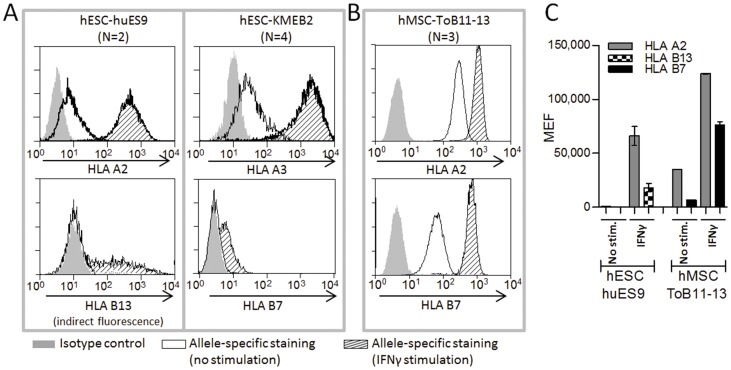
Expression of HLA-A and HLA-B in hESC and hMSC.Representative flow histograms showing HLA-A and -B expression in stem cell lines using allele-specific antibodies (anti-A2, -A3, -B7, and -B13). (A) In separate experiments, hESC lines (huES9 and KMEB2) showed a low expression of HLA-A alleles (A2 and A3, respectively) and no expression of the HLA-B alleles (B13 and B7, respectively). IFNγ stimulation up-regulated HLA-A alleles and induced of modest expression of HLA-B alleles. (B) Panel B shows representative flow histograms of an hMSC cell line (ToB11-13) both un-stimulated and IFNγ stimulated (72 hr) demonstrating a high constitutive expression of HLA-A2 and a relatively low expression of HLA-B7. Both antigens were up-regulated after stimulation with IFNγ. Panel (C) compares the expression of HLA-A and HLA-B between hESC (huES9) and hMSC (ToB11-13) during basal, un-induced conditions and after stimulation for 72 h with 25 ng/µl IFNγ. HLA expression was measured by flowcytometry as molecules of equivalent fluorochromes (MEF).